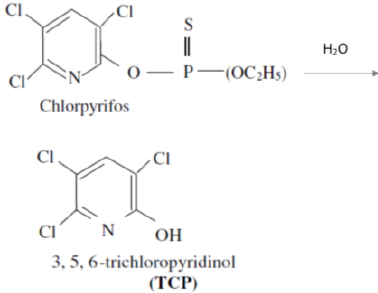
Figure 1. Chlorpyrifos and its hydrolysis product, trichloropyrridinol